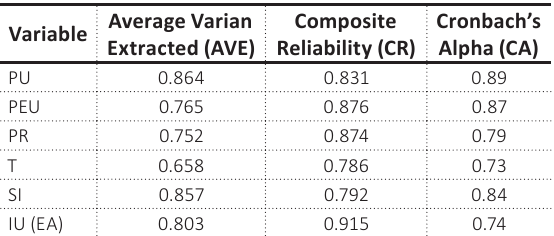
Table 4. Reliability and convergent validity